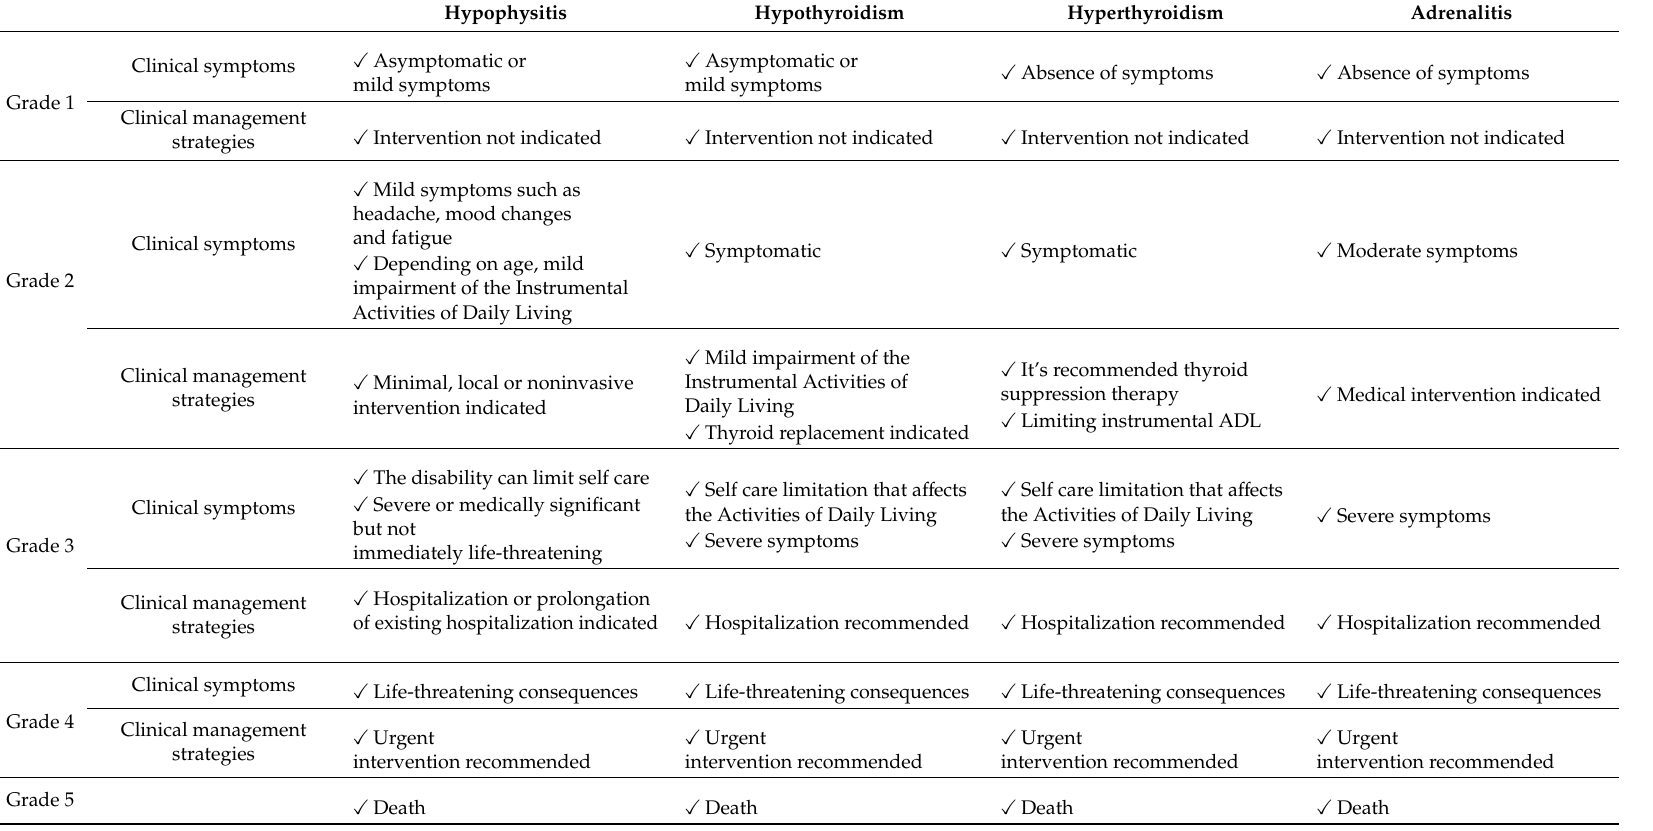
Table 1. List of endocrine adverse events and